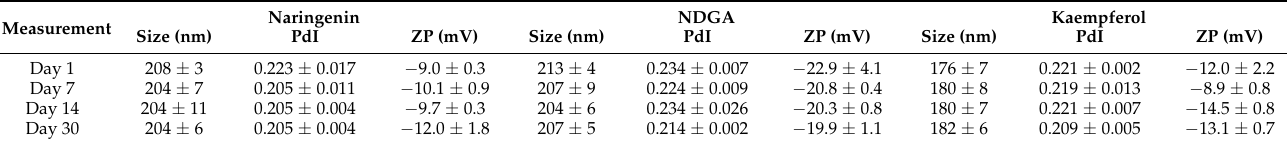
Table 2. The mean diameter (size), polydispersity index (PdI), and zeta potential (ZP) of the naringenin-, NDGC-, and kaempferol-loaded NLCs (mean ± SD, n = 3).